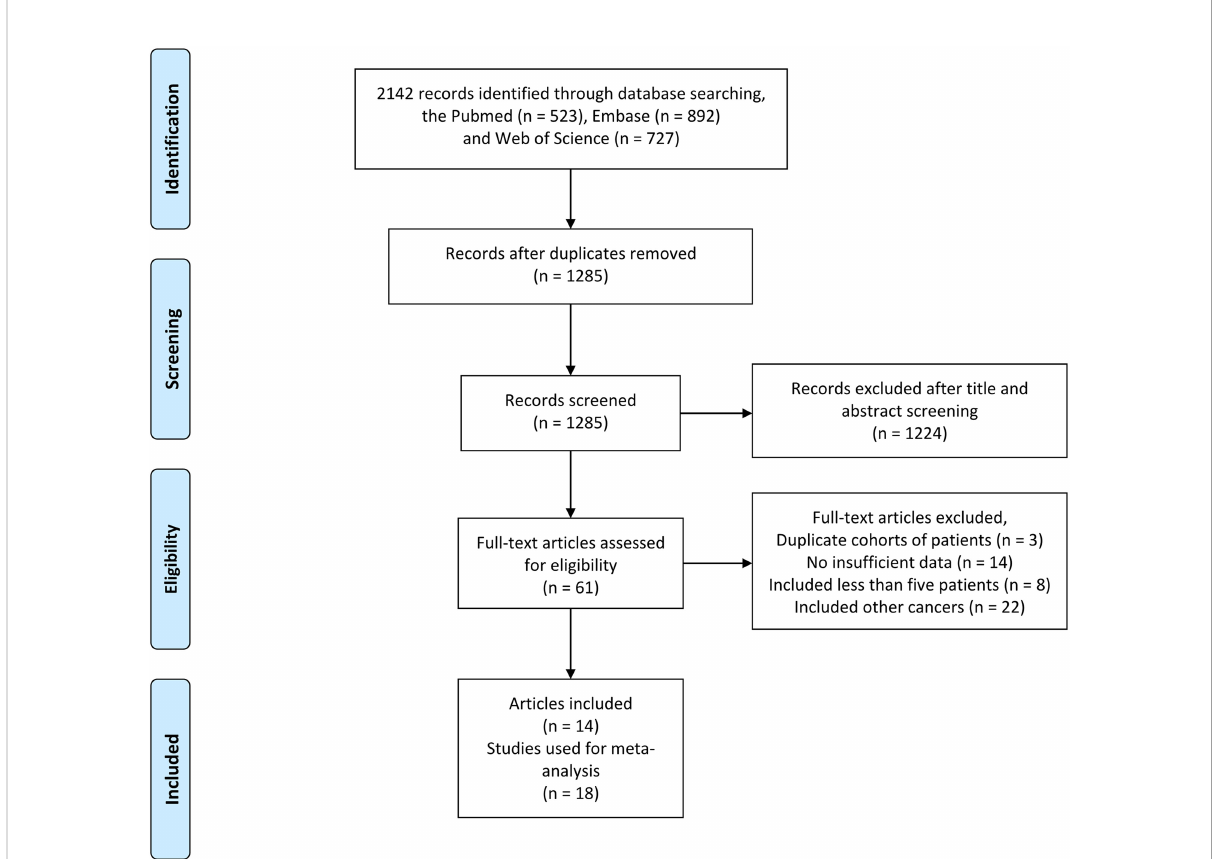
FIGURE 1 Flowchart outlining the search strategy and details on the studies fi nally included in the